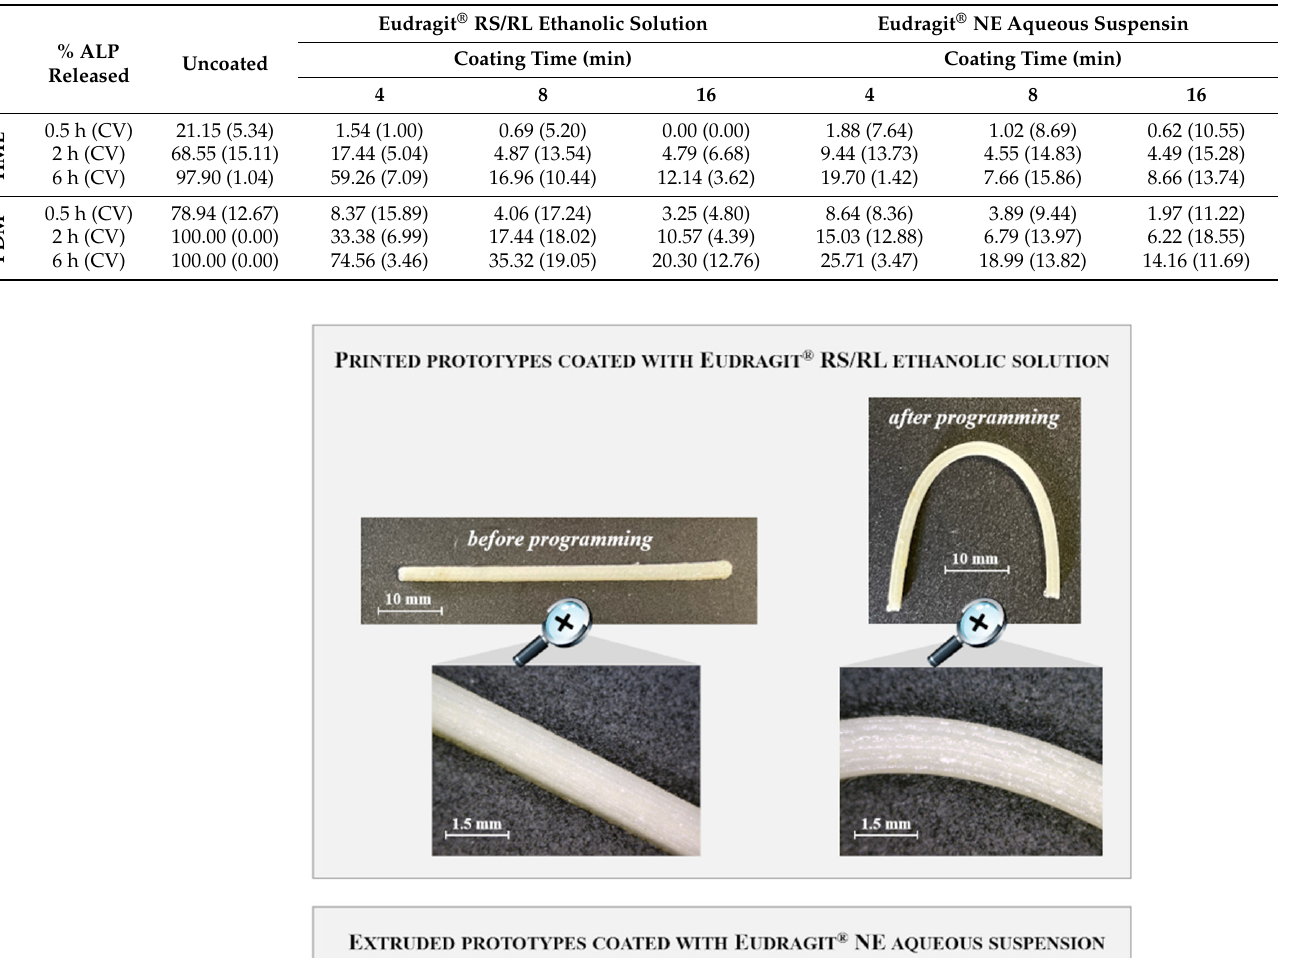
Table 5. Percentage of ALP released at different time points relevant to uncoated and coated samples.